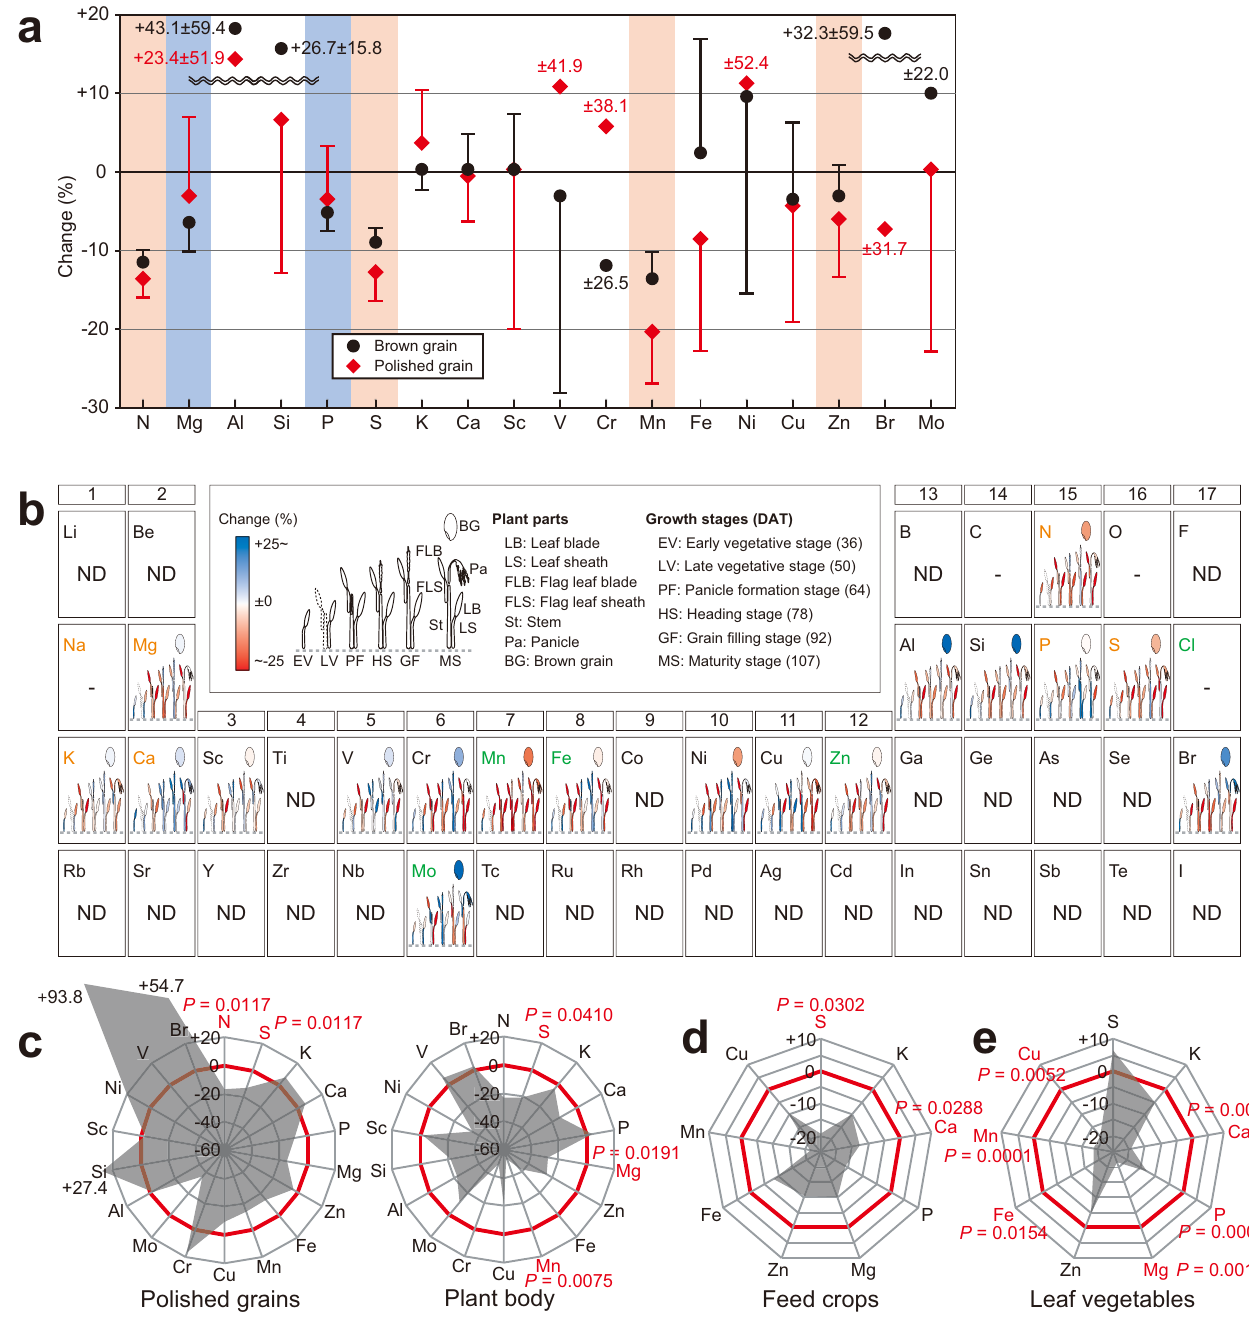
Fig 1. Influence of elevated [CO 2 ] on elemental content in crops. (a) Comparison of changes in the content of all tested elements under elevated [CO 2 ] between brown rice (black circles) and polished grains (red diamonds). Data are presented as the mean and one side of 95% confidence intervals (bars) of nine varieties. Red and blue backgrounds denote a significant difference ( P < 0.05), where previous work on brown grain has under- or overestimated, respectively, elemental changes in polished grains. For Al, Si, and Br, the values were off the scale of the y axis, as indicated by the wavy line. (b) Time-dependent changes in the elemental content of each part of the rice plant under elevated [CO 2 ]. Data are presented as the mean. (c) Percentage change in the elemental content of polished grains and plant body (“straw”) of rice (“ Koshihikari ”). (d) Estimated change in elemental content in feed crops under elevated [CO 2 ]. (e) Estimated change in elemental content in leaf vegetables under elevated [CO 2 ]. The raw data are provided in Table 1 and S4 Table. In (c)-(e), essential elements are arranged in decreasing order of intake requirement. Elements that decreased significantly ( P < 0.05) under elevated [CO 2 ] are shown in red.